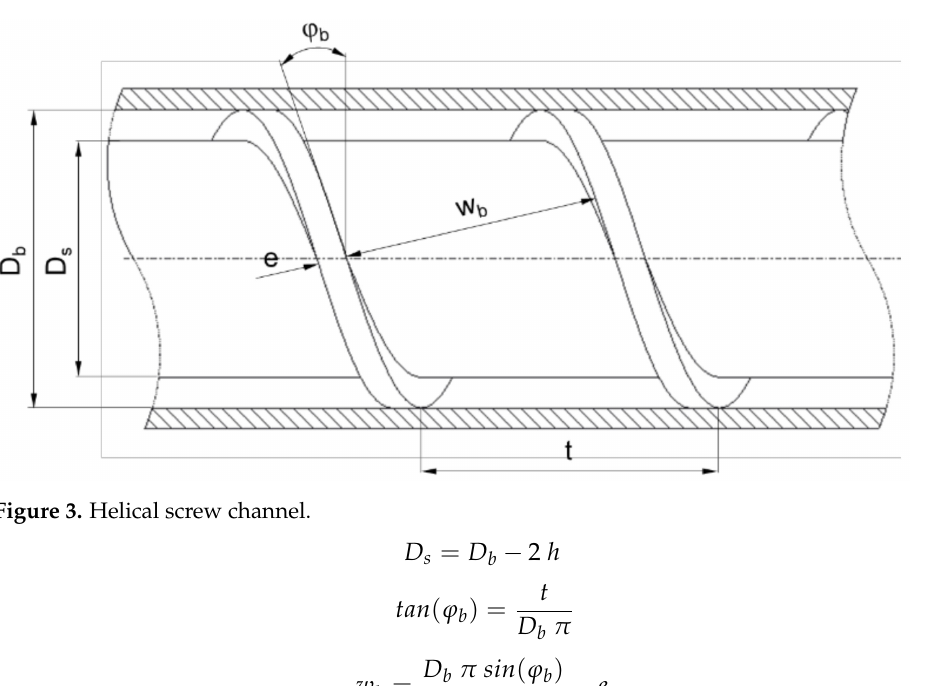
Figure 3. Helical screw channel.